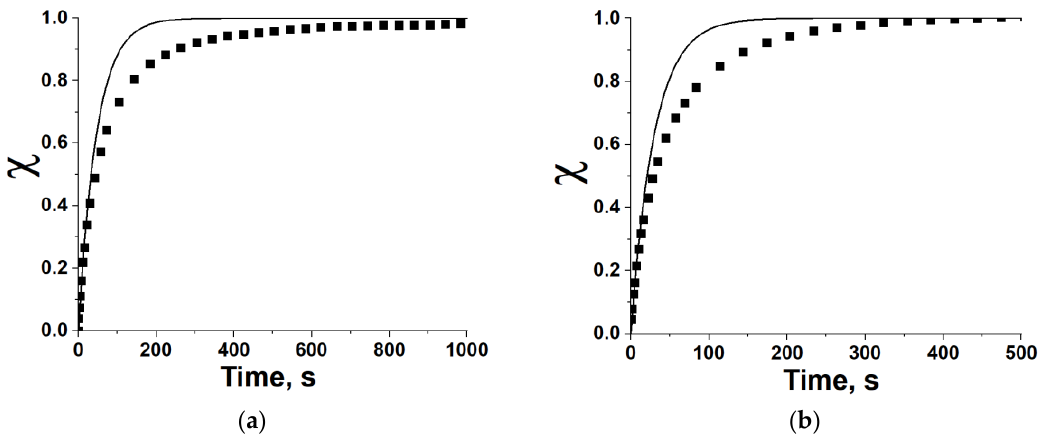
Figure 3. Dimensionless water uptake curves ( ■ ) for SWS-1L ( a ) and Fuji silica RD ( b ). Solid lines —